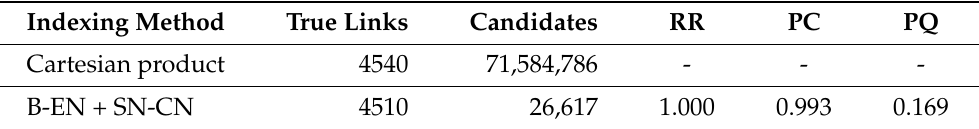
Table 4. Statistics for baseline and best variant of indexing measured on a testing subset.